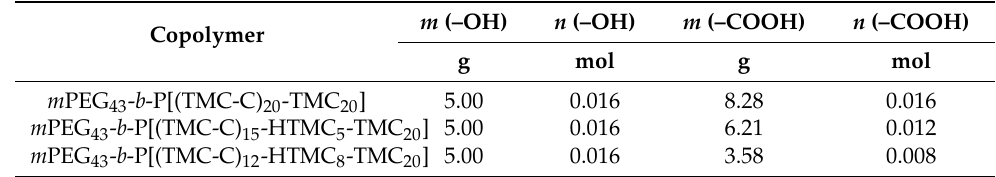
Table 1. Fabrication of mPEG 43 - b -P[(TMC-C) 20 − x -HTMC x -TMC y ] and 6-cholesteroxy-6-oxocaproic